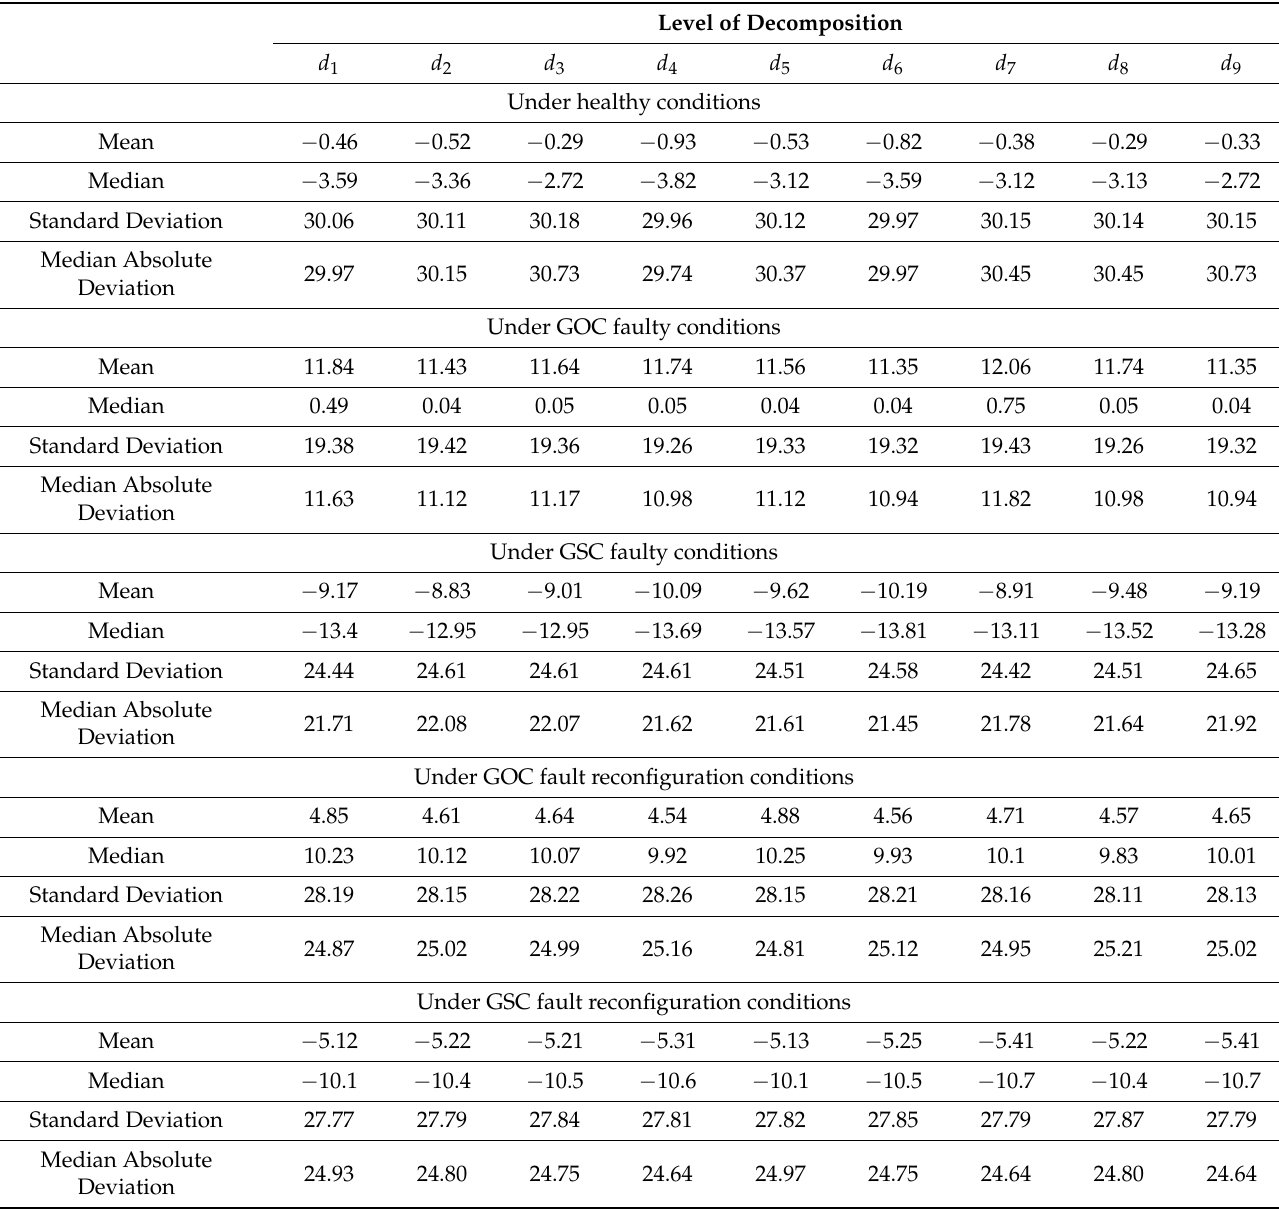
Table 4. Signatures measured under different conditions with respect to the level of